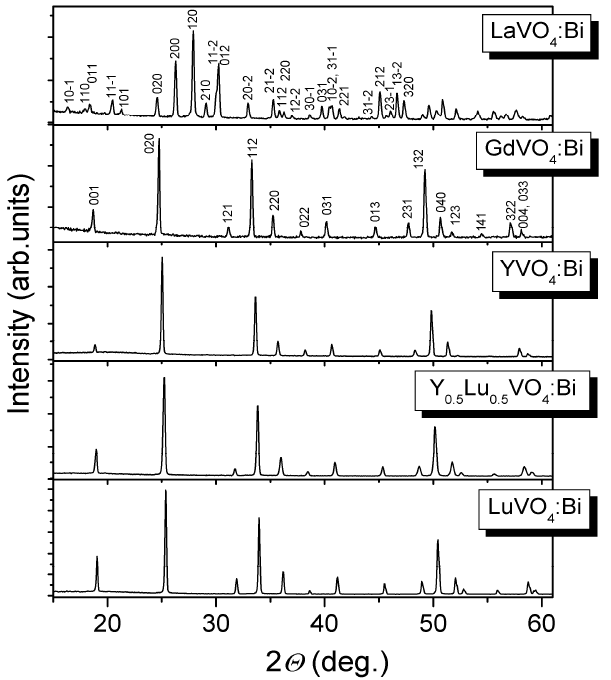
Figure 4. Representative parts of XRD patterns of the Bi 3+ -doped orthovanadates R VO 4 . The Miller indices are given for the monazite-type LaVO 4 :Bi and zircon-type R VO 4 :Bi